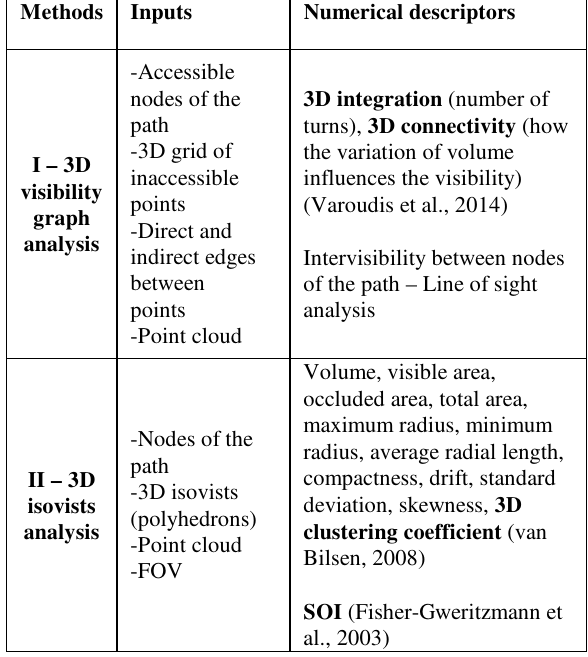
Table 1. Synthesis of the input data and numerical descriptors, which is possible to extract by the proposed approach; in bold are marked indexes that best describe the complexity of the